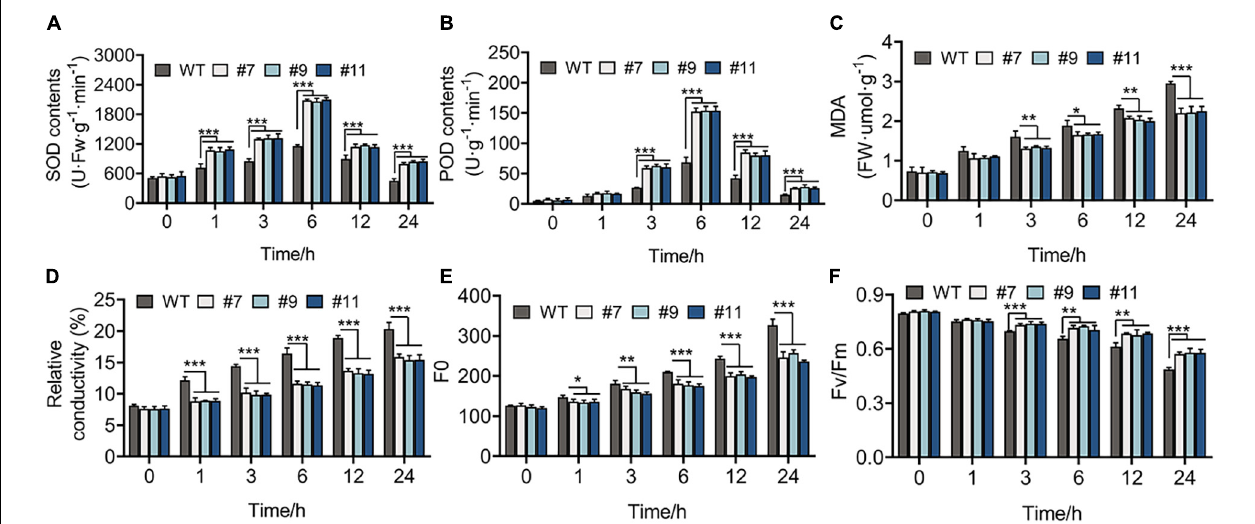
FIGURE 6 | Physiological indicators of 20-days-WT and OE lines that were treated under 4 ◦ C for 0, 1, 3, 6, 12, and 24 h, respectively. (A) Superoxide dismutase (SOD) activity, (B) peroxidase (POD) activity, (C) malondialdehyde (MDA) content, (D) relative conductivity, (E) initial fluorescence ( F o ), (F) the biggest electronic efficiency ( F v / F m ) changes between WT and OE lines provided an evidence for the growth of OE lines was less restricted than WT under chilling stress. * p < 0.05; ** p < 0.01; *** p < 0.001 in statistics.